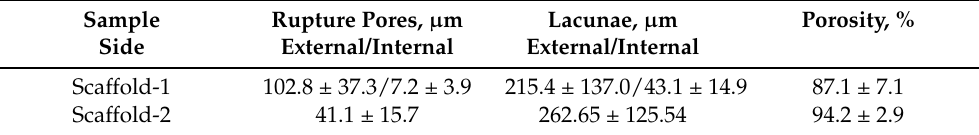
Table 1. Morphological features of porous scaffolds, n = 6.